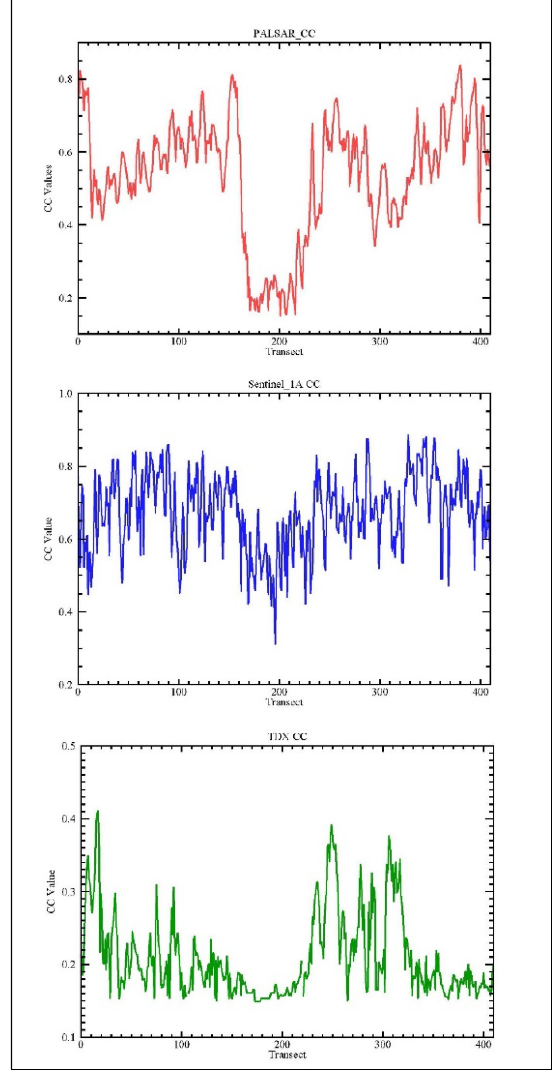
Figure 7 coherence coefficient value extracted from the profile line of Figure 6A: ‘PALSAR CC’ was the coherence coefficient value of PALSAR; ‘Sentinel-1A CC’ was the coherence coefficient value of Sentinel-1A. ‘TDX CC’ was the coherence coefficient value of